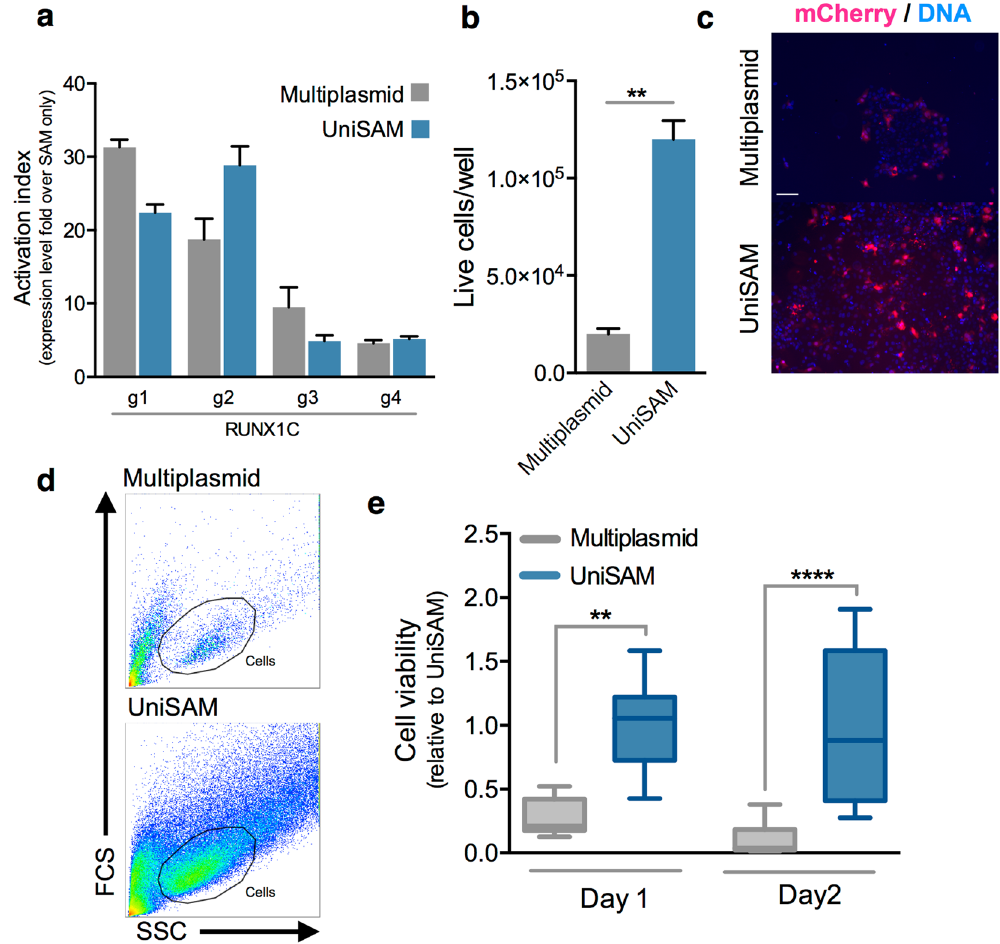
Figure 3. Direct comparison of the UniSAM system and the multiplasmid system. ( a ) Activation of RUNX1c using the UniSAM or multiplasmid systems with four different gRNAs (g1-g4) in HeLa (n = 3, Mann-Whitney t-Test). ( b ) Quantification of cell viability of hESCs one day after transfection as measured by Trypan Blue staining (n = 5; Mann-Whitney t-test, ** p < 0.01). ( c ) Visual microscopic appearance of transfected hESCs (identified by mCherry expression) one day after transfection indicating that there are more live cells using the UniSAM system (scale bar indicates 50 μ m). ( d ) Flow cytometry analysis of hESCs samples collected two days after transfection, gate indicates cells. ( e ) Comparison of the viable cells at day 1 and day 2 post transfection of hESCs, as measured by flow cytometry analyses of DAPI staining (n = 3; Dunn’s one-way Anova; ** p > 0.01, **** p <